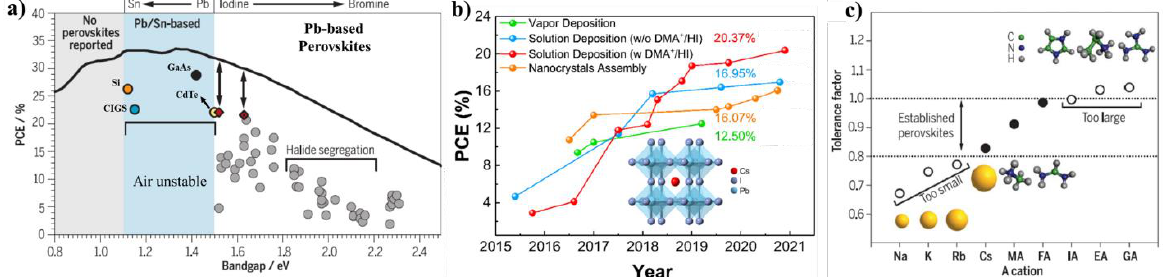
Figure 1. ( a ) Comparison of PCE among different materials, such as Si, CIGS, CdTe, GaAs, and perovskites. Note that APbI 3 PSCs show higher PCEs than the APbBr 3 ; ( b ) PCE performance of CsPbI 3 PSCs fabricated using various processing methods; ( c ) Tolerance factor of APbI 3 perovskites for various sized A cations. ( a , c ) adapted with permission from Ref. [17], Copyright 2017 from American Association for the Advancement of Science (AAAS) ( b ), adopted with permission from Ref. [10], Copyright 2021 Elsevier.